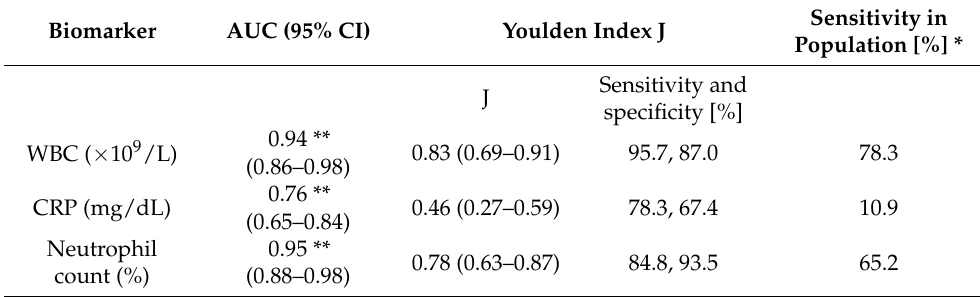
Table 4. The diagnostic potential of commonly used laboratory markers for acute